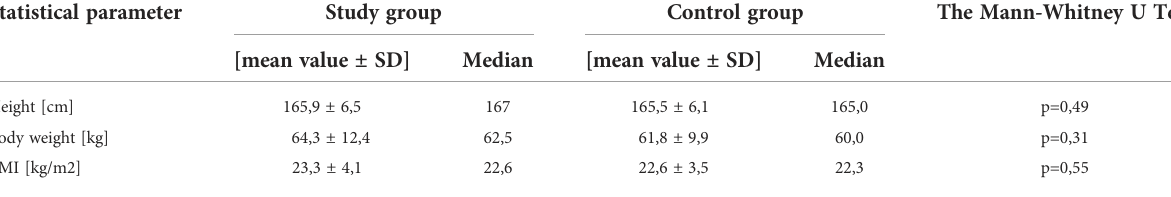
TABLE 2 Basic characteristics of anthropometric data in